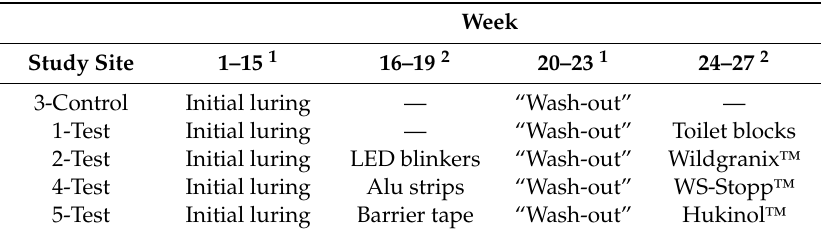
Table 1. Study plan for the five study sites (Figure 1).